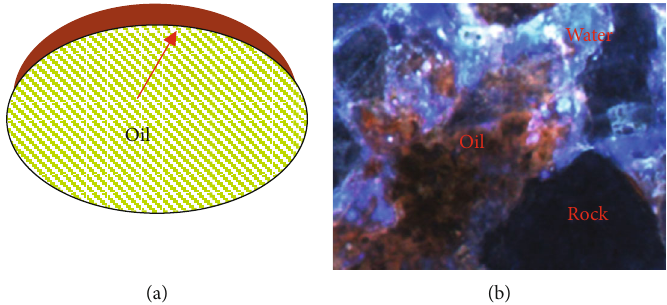
Figure 22: Reasons for residual oil production via adsorption force on the surface. (a) Schematic. (b) Fluorescent